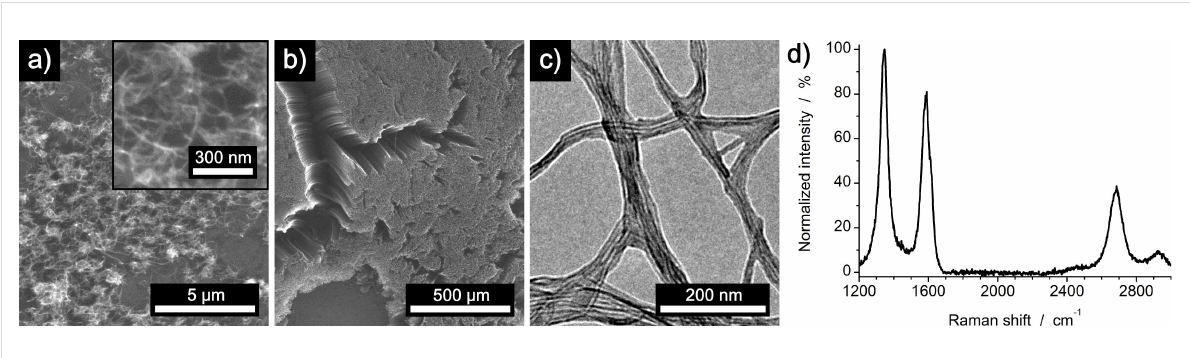
Figure 7: Characterization of CNTs grown on iron oxide nanoparticles/graphene obtained by a modified copper etching process using a solution of 1 M iron(III) chloride in 10% hydrochloric acid and an increased ratio of copper to FeCl 3 etchant. a) SEM images of substrate areas where randomly oriented growth of CNTs was observed (inset: higher magnification image). b) SEM image of an area with VACNTs. c) TEM and d) Raman spectros- copy of VACNTs confirms the synthesis of multiwalled carbon nanotubes with an average number of 4–7 walls.